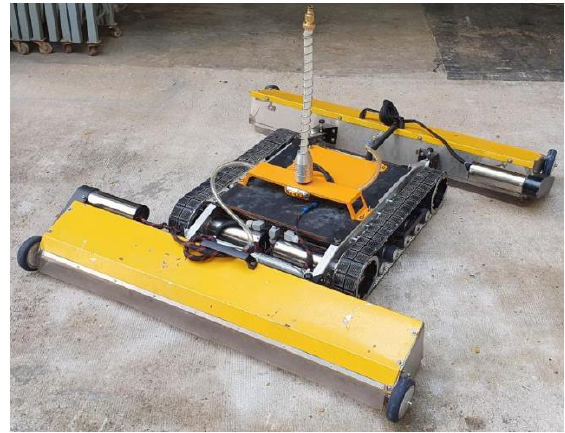
Figure 6. Prototype of PV cleaning